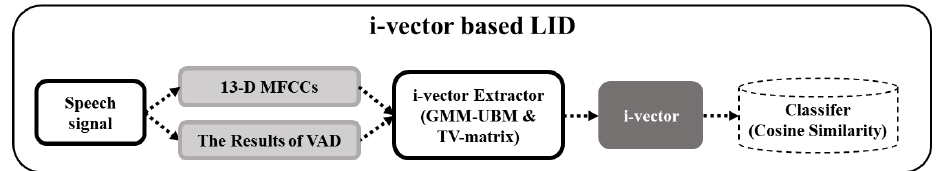
Figure 8. Procedure of the conventional i-vector-based LID approach.